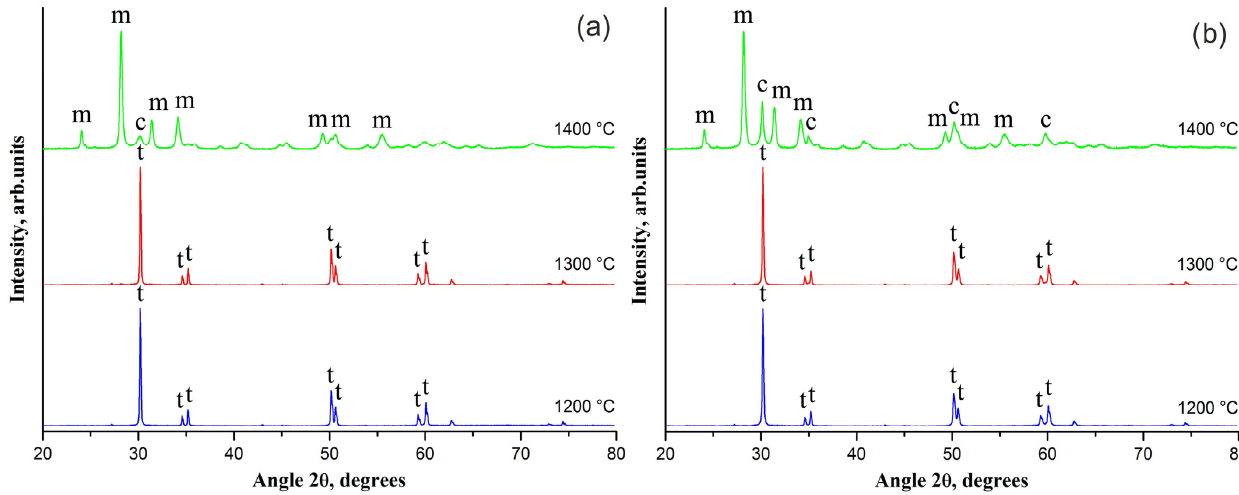
Figure 2. The XRD patterns of ( a ) 2-wt% CaO-ZrO 2 and ( b ) 3-wt% CaO-ZrO 2 ceramics sintered at temperatures in the range of 1200–1400 °C; m, t, c—the most intense characteristic peaks of m-ZrO 2 , t-ZrO 2 and c-ZrO 2 , respectively. Figure 3 presents the effect of the sintering temperature on phase composition of the fabricated TZP ceramic doped by 2-wt% CaO.